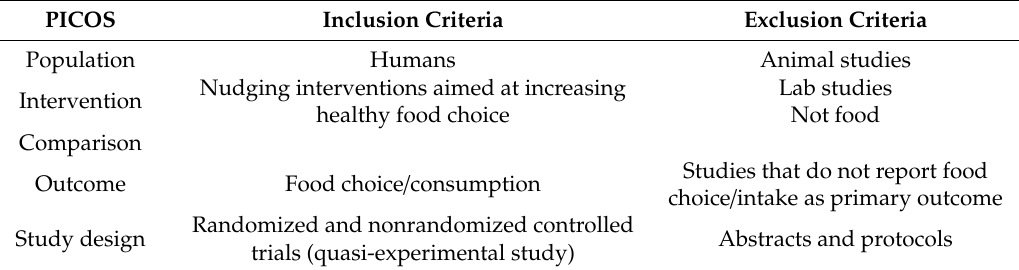
Table 1. Inclusion and exclusion